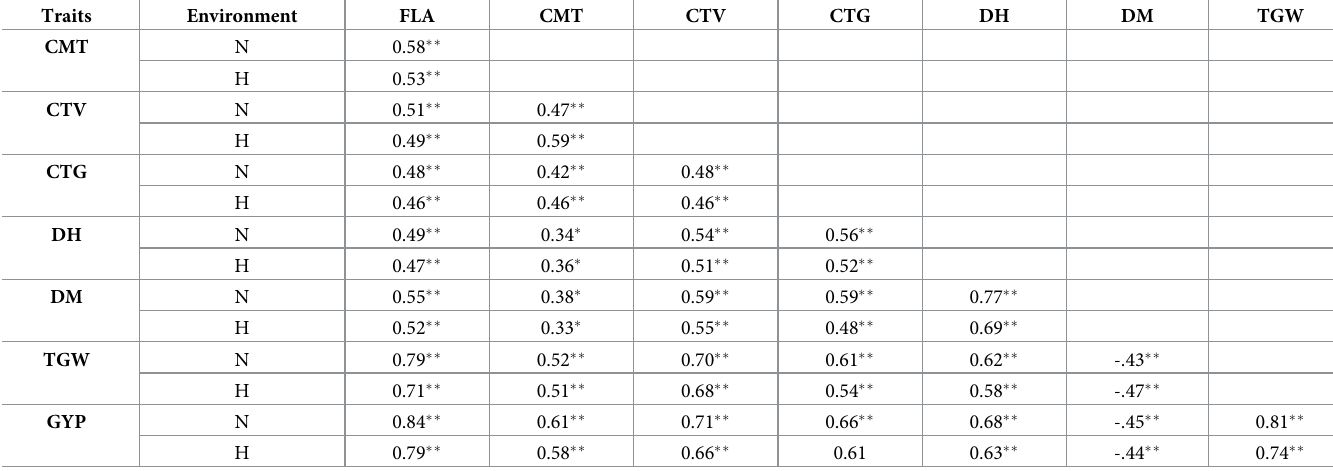
Table 1. Correlation coefficients of physiological and yield traits based on data average over year in normal and heat stress conditions. Traits